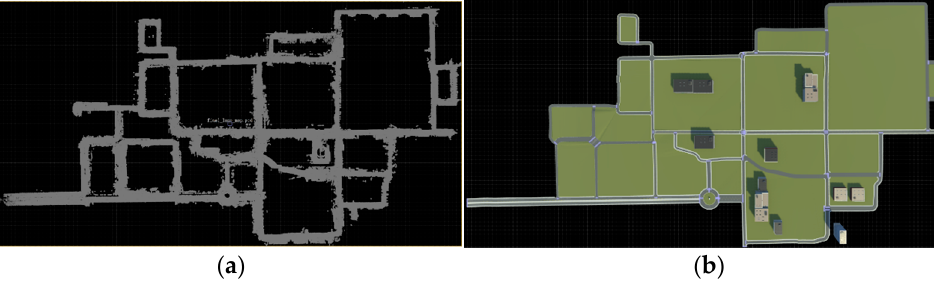
Table 4. Time costs of different routing methods in a real road